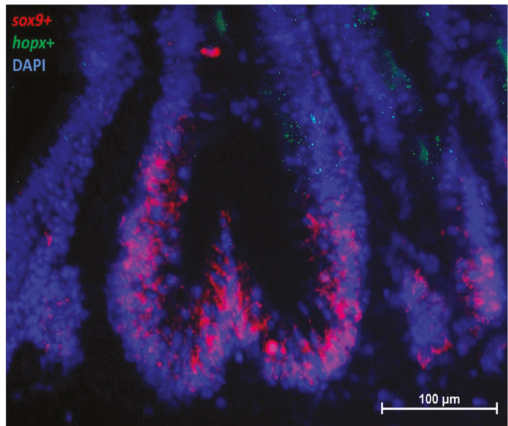
Figure 12. In situ hybridization of sox9 mRNA (red dots) and hopx (green dots) cells in the second segment of the mid-intestine. The two genes were expressed at the base and in the lower half of the fold, respectively.